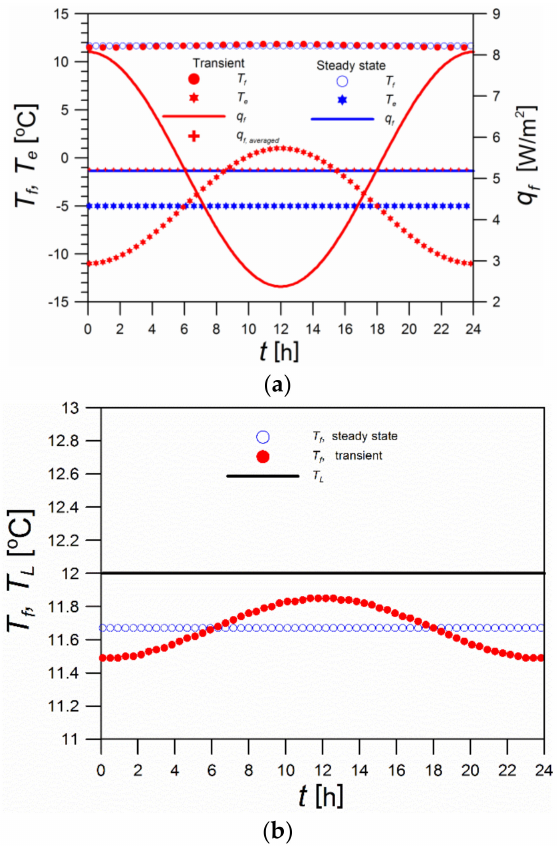
Figure 9. ( a ) Temporal course of ambient temperature, ATI layer temperature, and heat flux supplied to the ATI layer under steady and transient conditions; ( b ) temporal course of ATI layer temperature under steady and transient